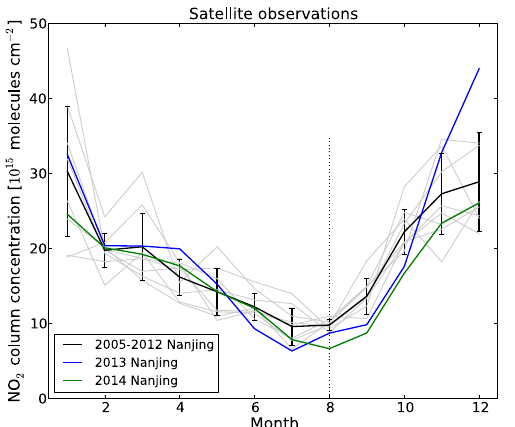
Figure 9. The monthly averages of OMI satellite observations of tropospheric NO 2 concentrations. The solid lines are the measure- ments over the Nanjing area. The grey lines are the monthly aver- ages for each year from 2005 to 2012 to indicate the annual vari- ability. The black lines show the average value for the years from 2005 to 2012. The bars are the standard deviations of monthly NO 2 observations from 2005 to 2012.